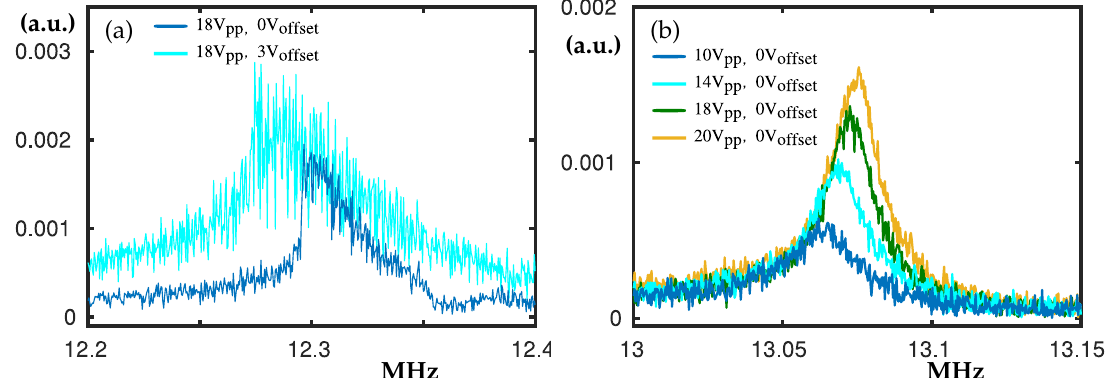
Figure 6. Experimental frequency swipe up centred at about 12.3 MHz and 13.05 MHz. In panel ( a ) V pp = 18 V. The blue and cyan curves denote V of f = 0 V and V of f = 3 V, respectively. In panel ( b ) V of f = 0 V. The the blue, cyan, green and yellow curves denote: V pp = 10 V, V pp = 14 V, V pp = 18 V, V pp = 20 V. The peak at about 12.3 MHz appears at twice the frequency of the peak shown in Figure 4a. 3.5. The Peaks at 13.54 MHz and 14.3